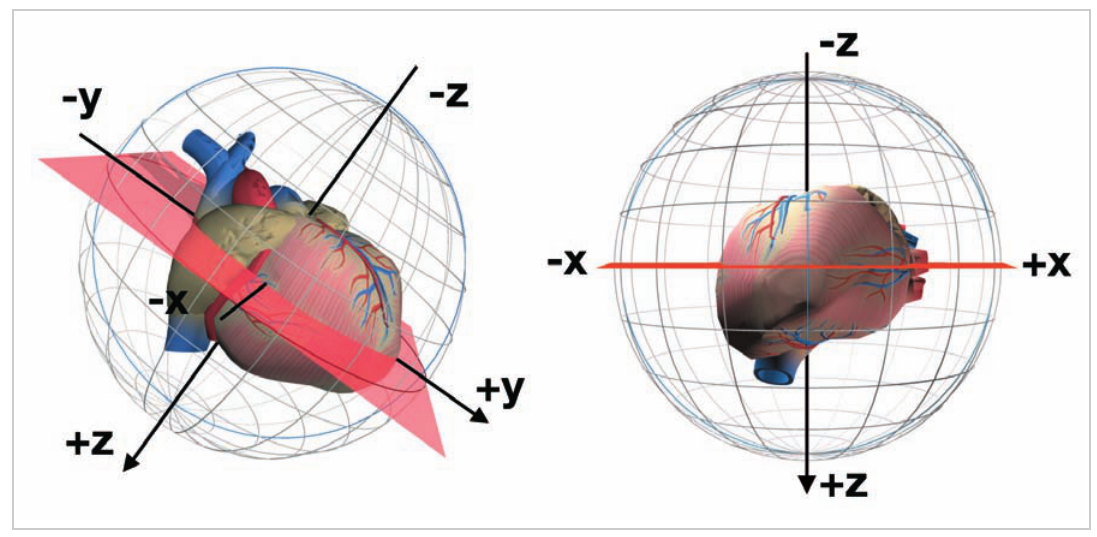
Projections x, y, and z. The projections x, y, and z are oriented relative to the heart. The OSP (red in the drawing) is the main plane, defined by the projections x and y. A globe is defined around the heart, with its centre at the origin of the orthogonal system, ie, at the point where the three rectangular axes x, y, and z cross. Degrees of longitude (angle alpha) and of latitude (angle beta) define precisely every point on the globe around the heart. The positive end of the y-axis projects to the apex of the heart and pierces the imaginary globe at b = 0° latitude and a = 90° longitude. The negative end of the y-axis lies at b = 0° latitude and a = –90° longitude. The spatial orientation of any vector measured can be defined with its projection onto the globe positioned around the heart.